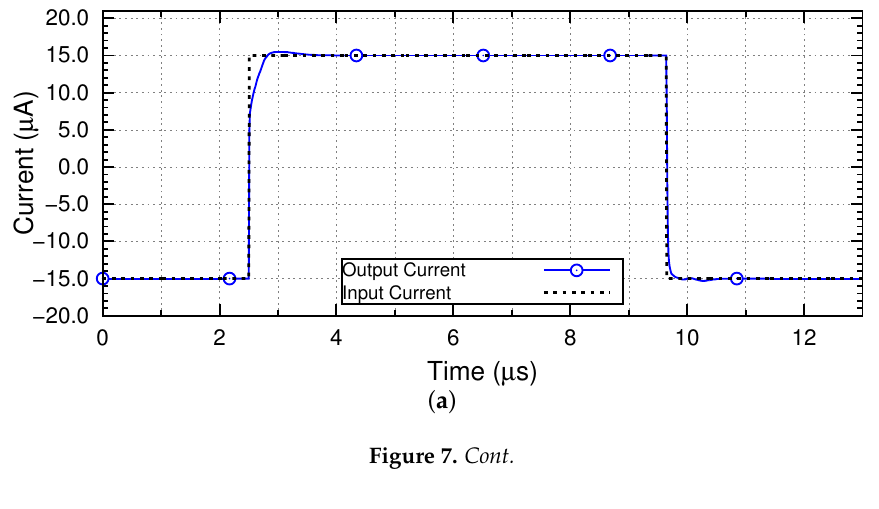
Figure 6. THD for a 30 µ A pp input current versus frequency.